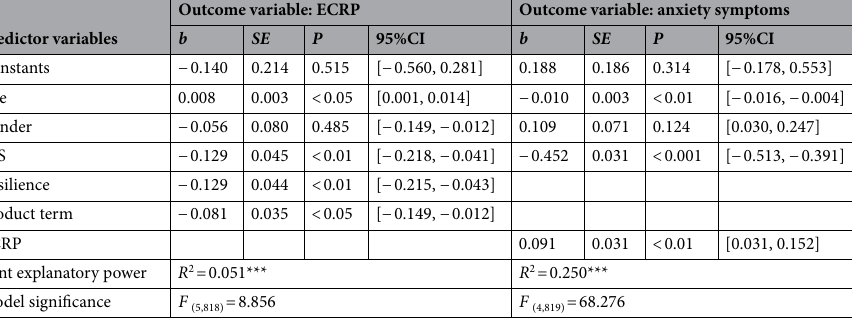
Table 2. Results of the mediating effects model with moderation. *** P < 0.001, The product term is the product for PSS and resilience.